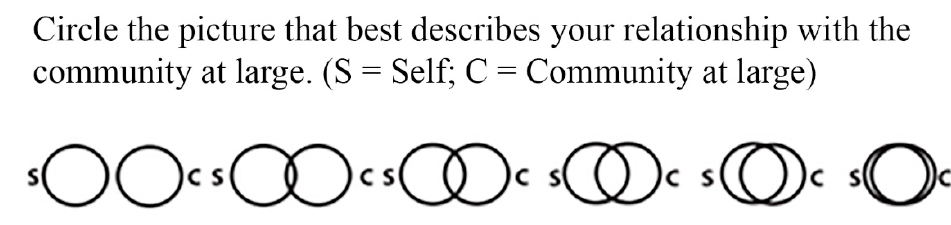
Figure 2. The inclusion of Community in the Self (ICS) Scale [46].